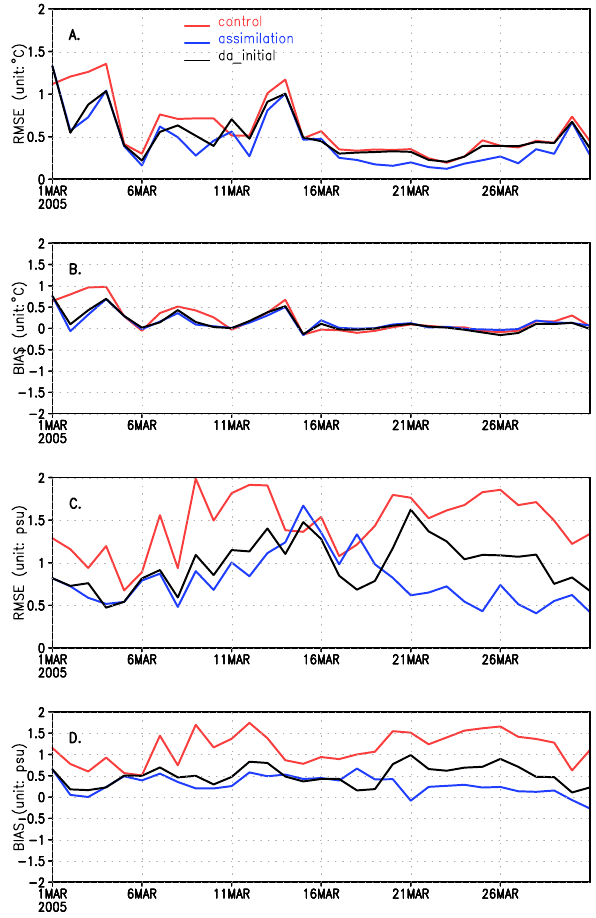
Fig. 10. The daily spatially averaged rmse and bias of innovation of both temperature (A, B) and salinity (C, D) for the experiments with 3DVAR data assimilation (blue line), without data assimila- tion (red line), as well as one month non-data assimilation run with assimilated initial value (black line) throughout March